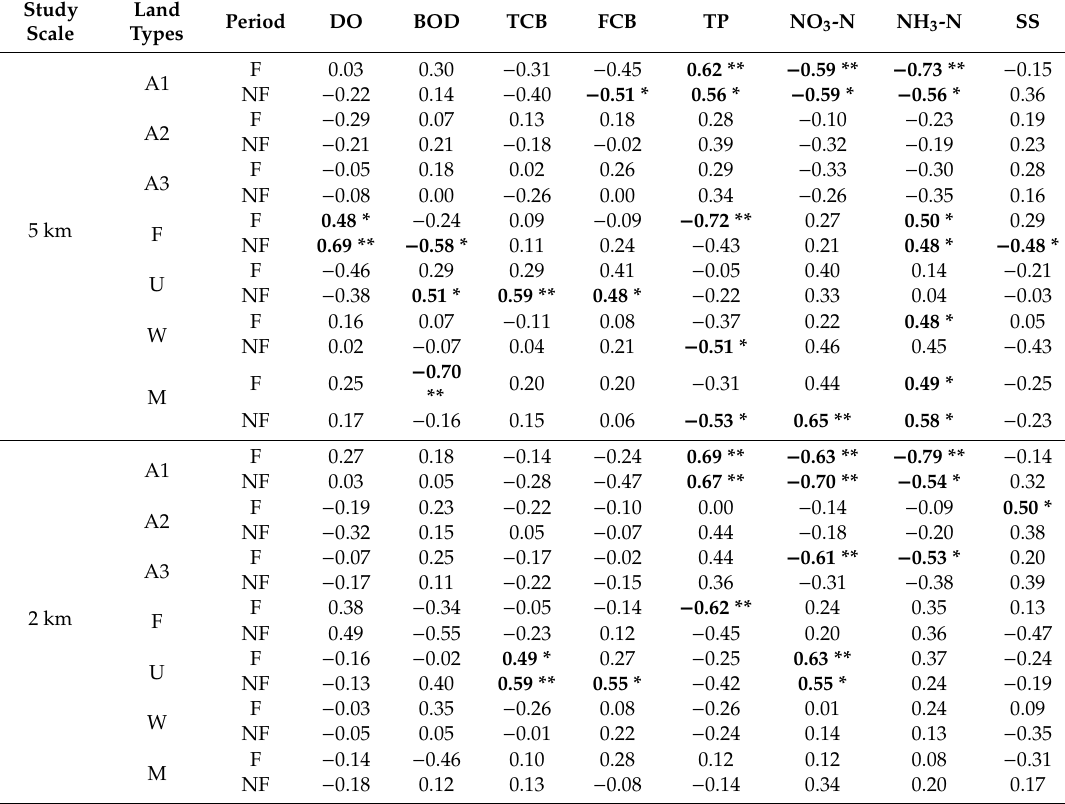
Table 4. Correlation between proportions of land use types and water quality parameters in 2015. Study